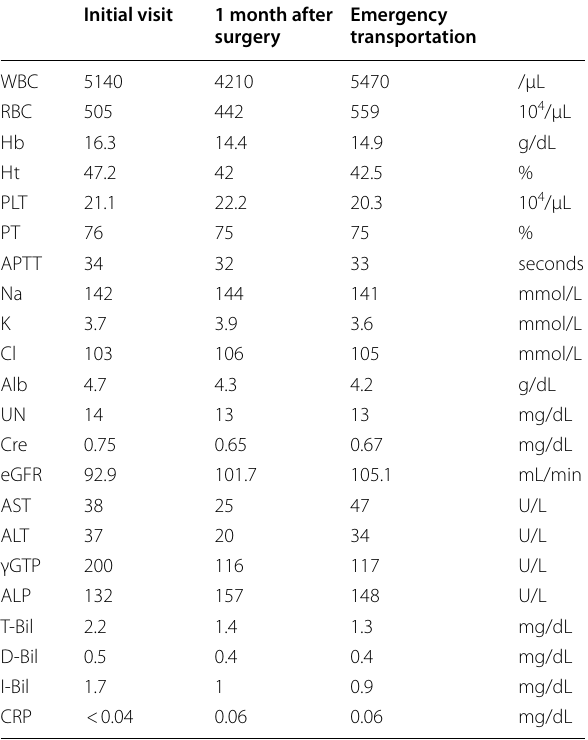
Table 1 Laboratory test at admission, first visit after discharge, and emergency